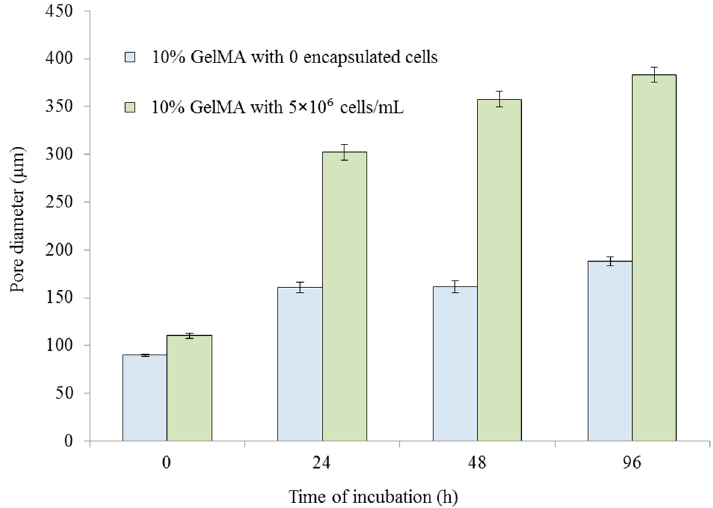
Figure 8. Pore sizes with an increase in incubation time for the cell-encapsulated GelMA hydrogels. The error bars indicate the standard deviation